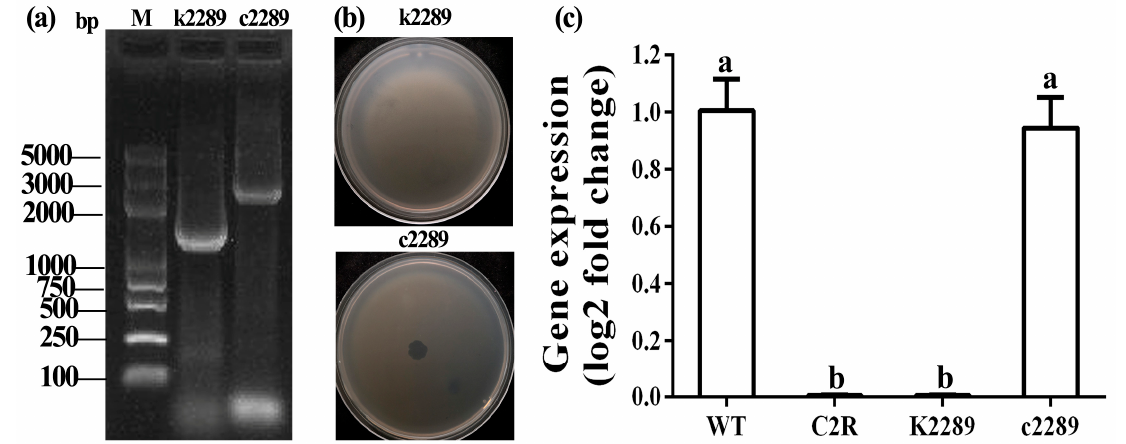
Figure 4. Verification of glycosyltransferase gene in phage resistance by constructing insertional mutant k2289 and complement c2289. ( a ) PCR verification of k2289 and c2289. ( b ) Spot assays of phage X2 on k2289 and c2289. ( c ) Expression of glycosyltransferase gene by qRT-PCR. Data were presented as means ± standard errors ( n = 3). Columns with different letters are significantly different according to LSD test ( p < 0.05).